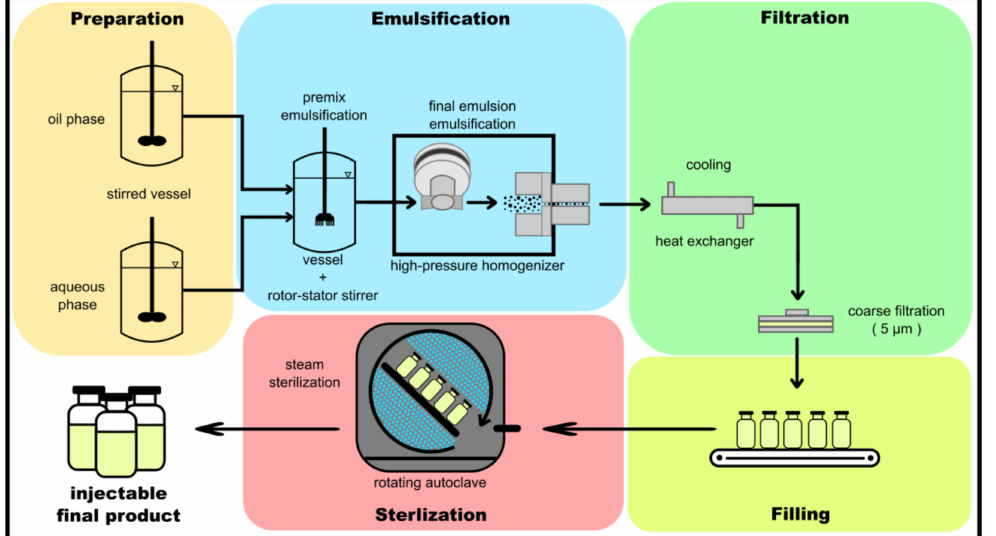
Figure 1. Manufacturing process for parenteral lipid emulsions. This starts with the preparation of aqueous and oil phases, followed by coarse and then fine emulsification, cooling, filtration, filling, and sterilization of the injectable, final